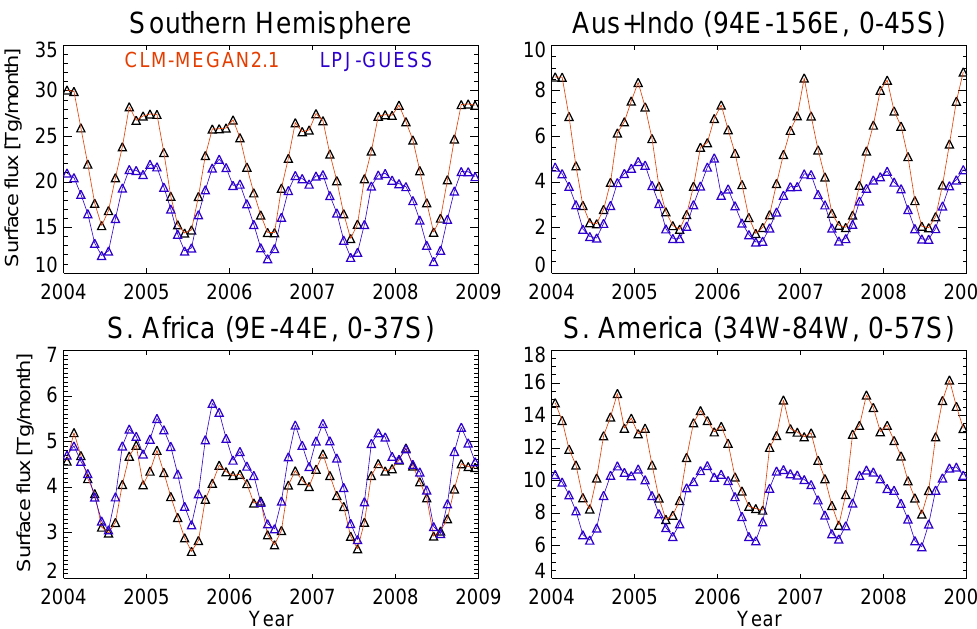
Figure 1. Regional emission fluxes for isoprene between 2004 and 2008 from the CLM-MEGANv2.1 and LPJ-GUESS emission inventories.